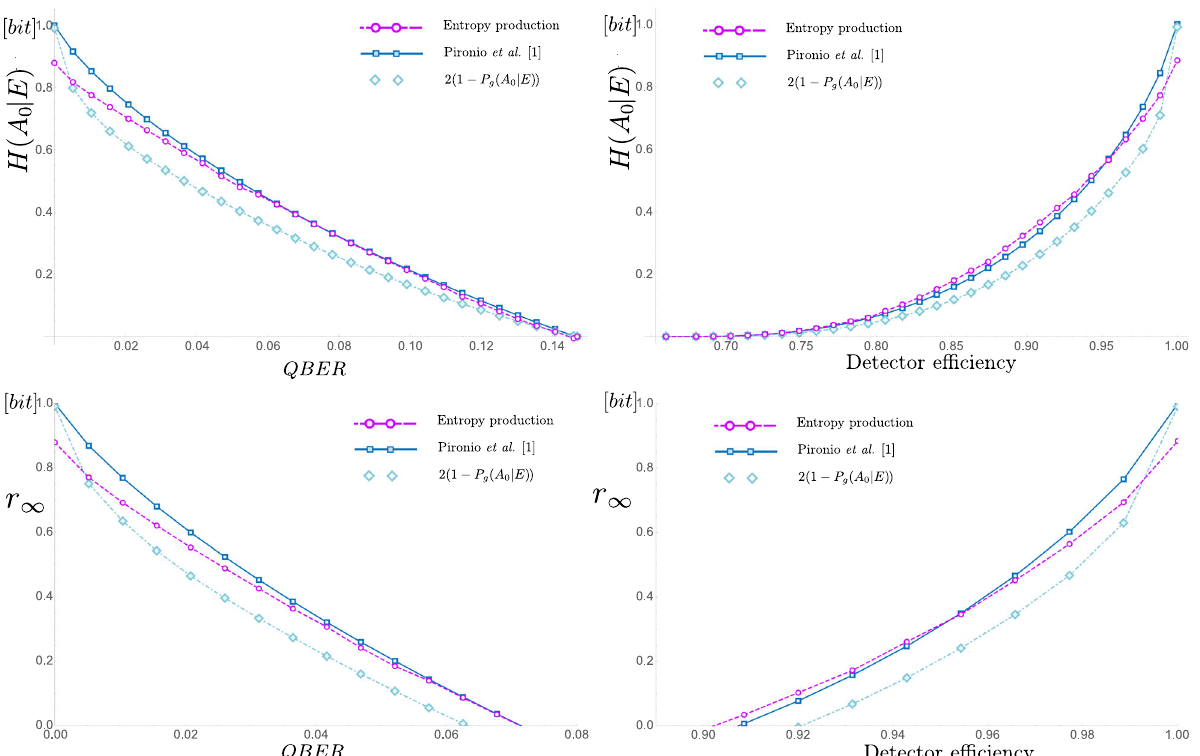
Fig. 3 2-input 2-output DI protocols, H ( A 0 ∣ E ) and r ∞ (in base 2). Lower bounds on entropy H ( A 0 ∣ E ) and key rate r ∞ , as a function of depolarizing noise (for the scenario studied in 1 ) or detection ef fi ciency (for the scenario studied in 43 , which optimizes the state and measurements to achieve maximal CHSH value). For the latter, r ∞ was computed by optimizing the key-generating measurement B 0 alone to minimize the value H ( A 0 ∣ B 0 ), without changing the state and other measurements from those in 43 . Also, to yield higher key rates, the key- generating measurement B 0 was preserved as a 3-outcome measurement (following 60 ) rather than postprocessing it to 2 outcomes. It can be seen from the graph that our bounds are either close to or slightly better than the best previous result 1 for these scenarios, which was based on the CHSH value alone. For comparison, we also show the indirect bounds obtained by using the inequality H ( A 0 ∣ E ) ≥ 2(1 − P g ( A 0 ∣ E )) (in base